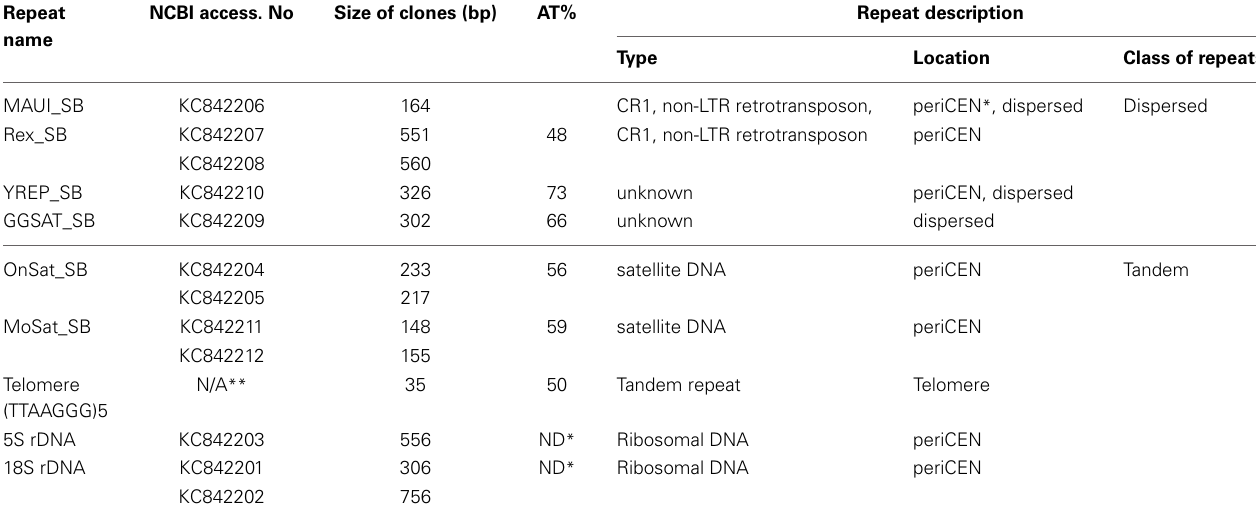
Table 1 | The inventory and characterization of nine repeats isolated from the Asian seabass transcriptome and